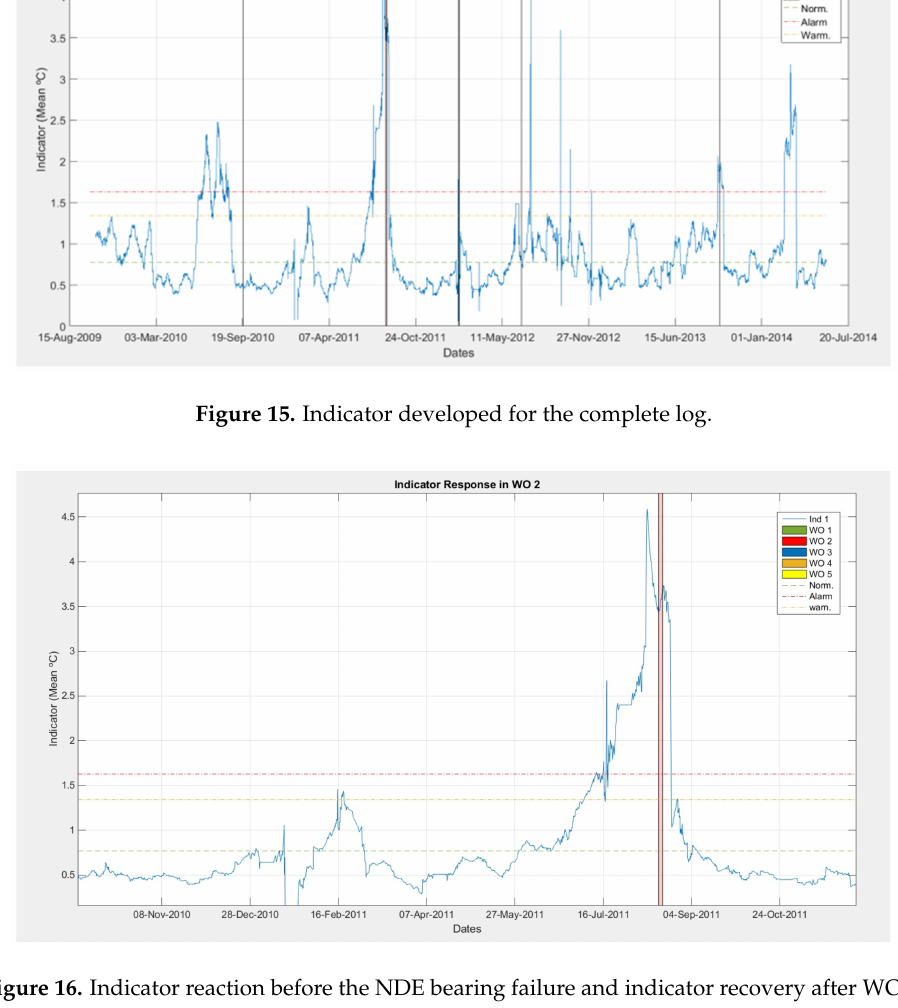
Figure 16. Indicator reaction before the NDE bearing failure and indicator recovery after WO